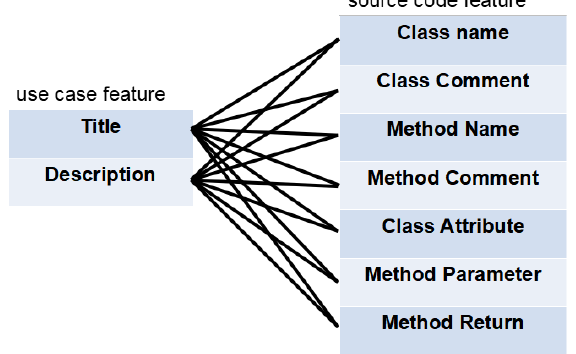
Figure 6. Computation of the similarity between each feature.